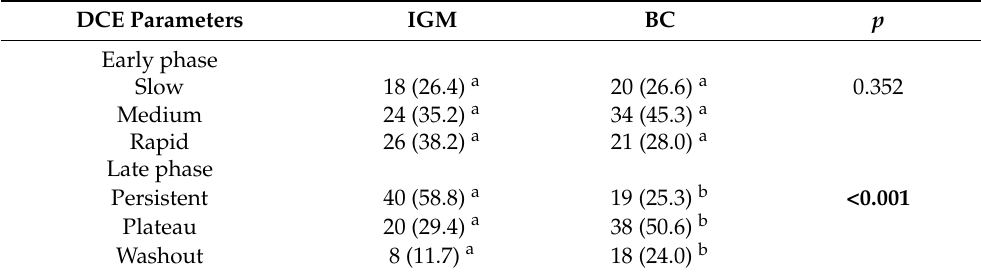
Table 4. Kinetic features in DCE MRI for differentiating IGM from breast cancer.